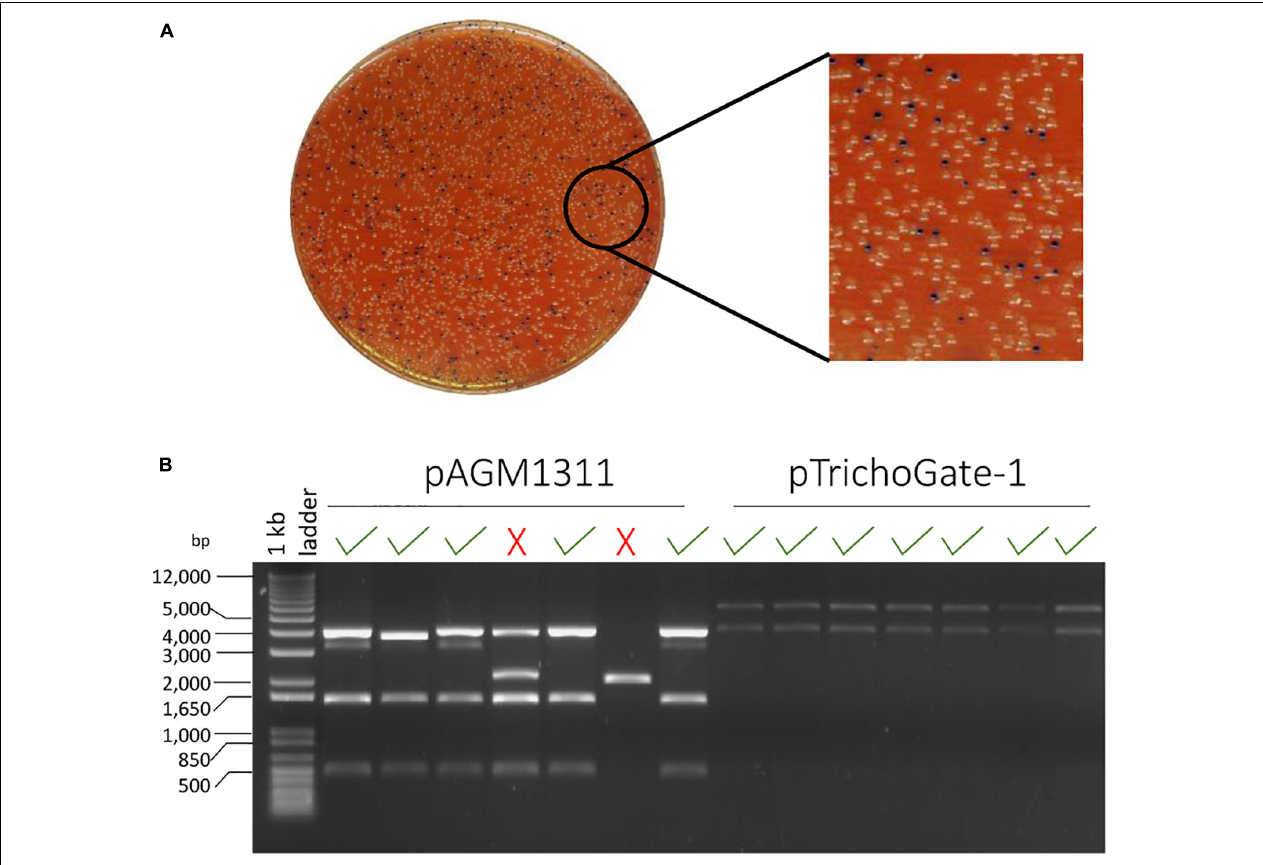
FIGURE 2 | The efficiency of TrichoGate cloning system. (A) Luria-Bertani (LB) plate supplemented with 50 µ g/mL kanamycin for selection of E. coli transformants containing constructs that were created using TrichoGate cloning system. Blue/white screening, E. coli cells transformed with vectors containing correct recombinant DNA should be white. (B) Restriction of plasmid DNA of minipreps from seven white colonies digested by Eco RV and run on a 1% agarose gel to verify √ insertion of the correct ( ) or incorrect (X) construct by using two different receptor vectors: pAGM1311 and pTrichoGate-1. DNA from 70% (pAGM1311) and 100% (pTrichoGate-1) from white colonies analyzed have the desire restriction